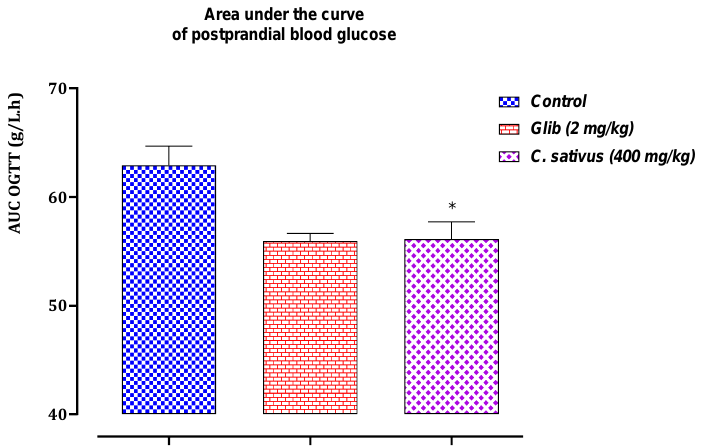
with the control.